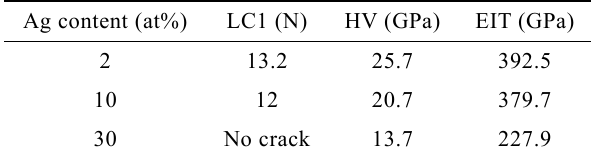
Fig. 3 Surface morphologies of the coatings: (a) TiN–Ag coating with 2 at% Ag content, (e) TiN–Ag coating with 10 at% Ag content, (i) TiN–Ag coating with 30 at% Ag content, and (b–d, f–h, j–l) the surface elements distribution in green frames by EDS corresponding to (a, e, and i). Table 3 Critical load (LC1), Vickers hardness (HV), and module of elasticity (EIT) of TiN–Ag coatings with different Ag